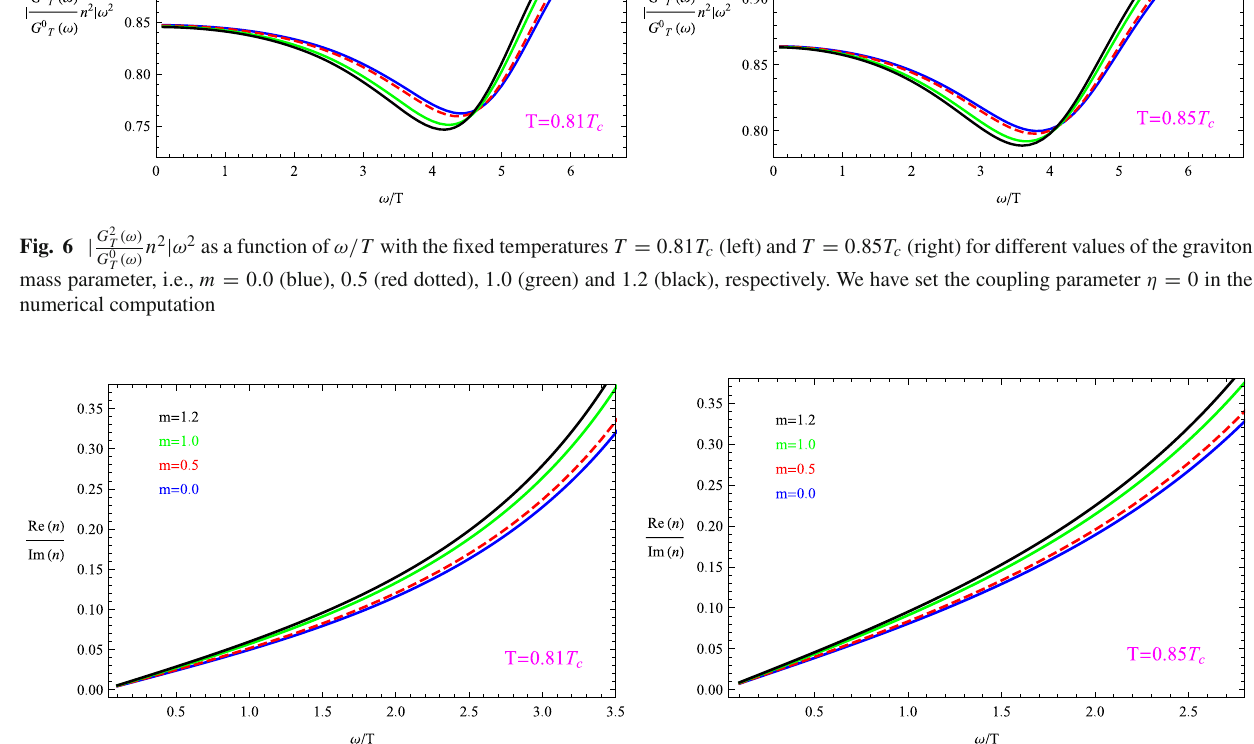
(green) and 1 . 2 (black), respectively. We have set the coupling param- eter η = 0 in the numerical